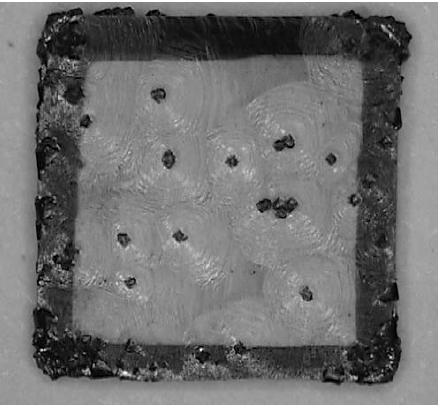
Figure 1. The surface of large thickness diamond with defects on the surface and facets (substrate size—5 × 5 × 0.5 mm, deposited diamond layer thickness—0.5 mm).